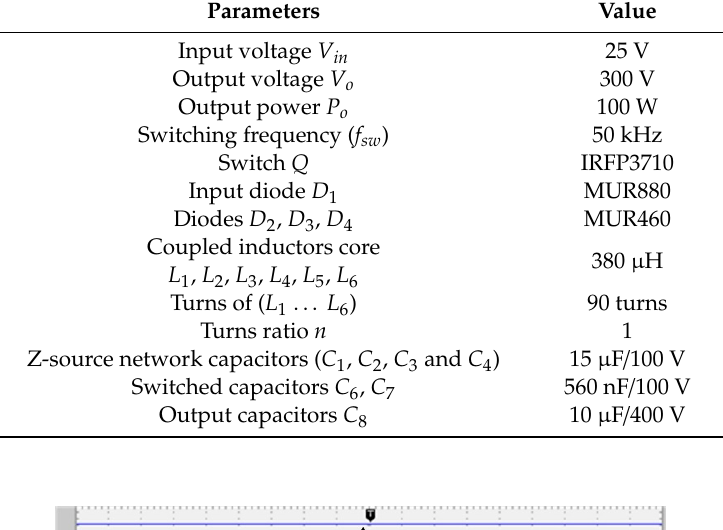
Table 2. Important parameters of the implemented prototype.